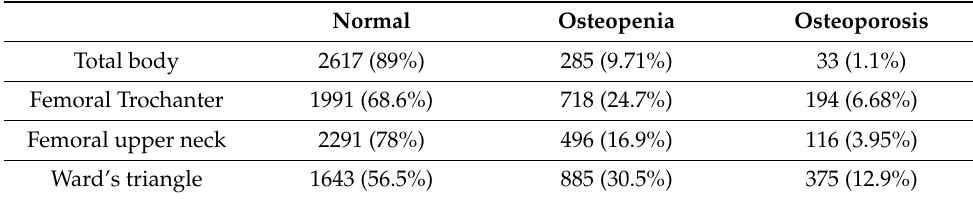
Table 2. Summary of bone mineral density (BMD) T-score measurements.